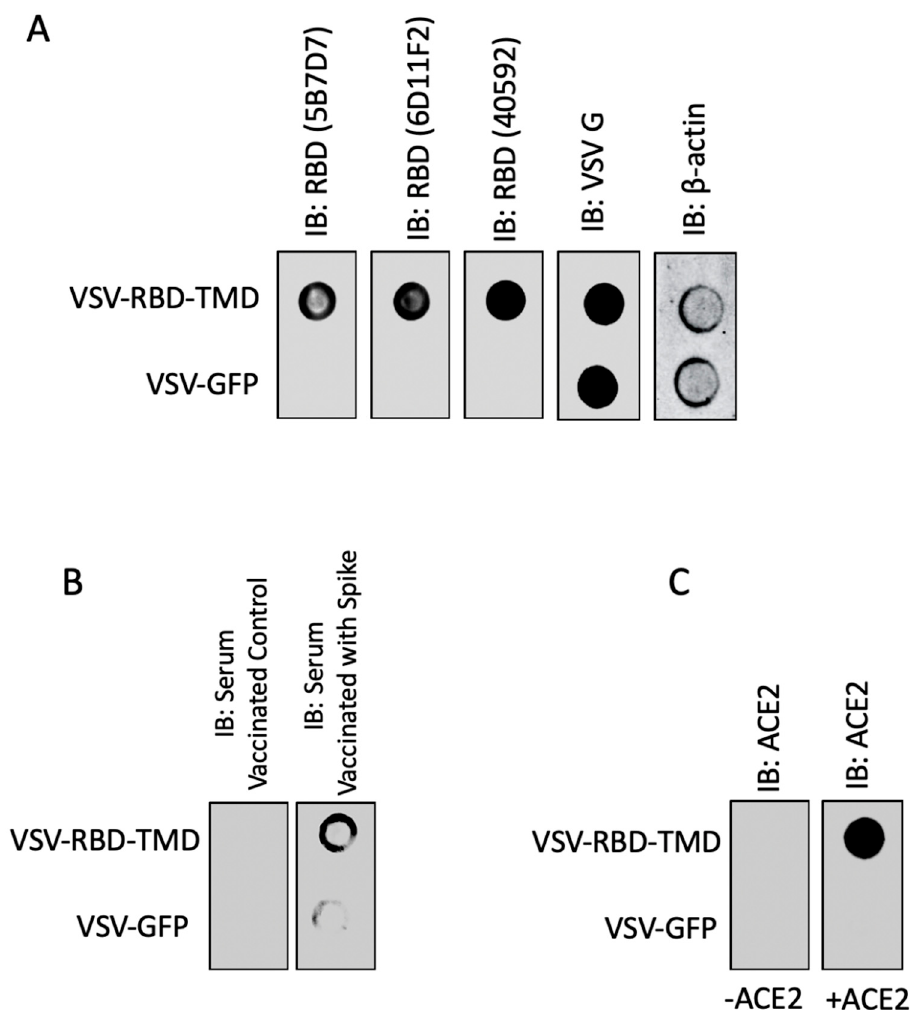
Figure 3. RBD-TMD fusion protein retains antigenic and functional conformation. U-2 OS cells were infected with vesicular stomatitis virus (VSV) expressing either GFP or RBD-TMD (MOI = 0.1). Twenty-four hours post-infection, dot blot analysis were performed, and membranes were probed using ( A ) RBD antibodies, ( B ) sera from mice immunized with control or SARS-CoV-2 spike, or ( C ) a combination of recombinant angiotensin-converting enzyme 2 (ACE2) protein and ACE2 antibody. VSV-G and β -actin indicate equal virus and loading levels, respectively.